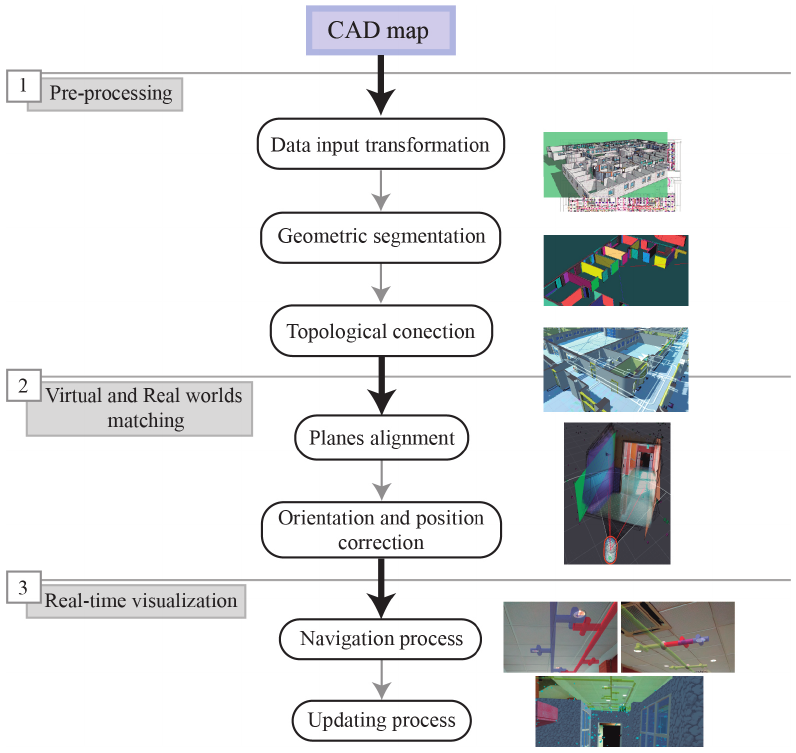
Figure 1. The flow diagram of the proposed